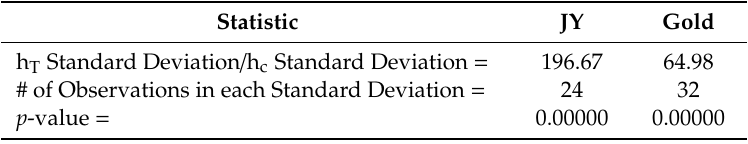
Table 5. Ratio of the HRs’ Standard Deviations (HRs based on Indian Rps).